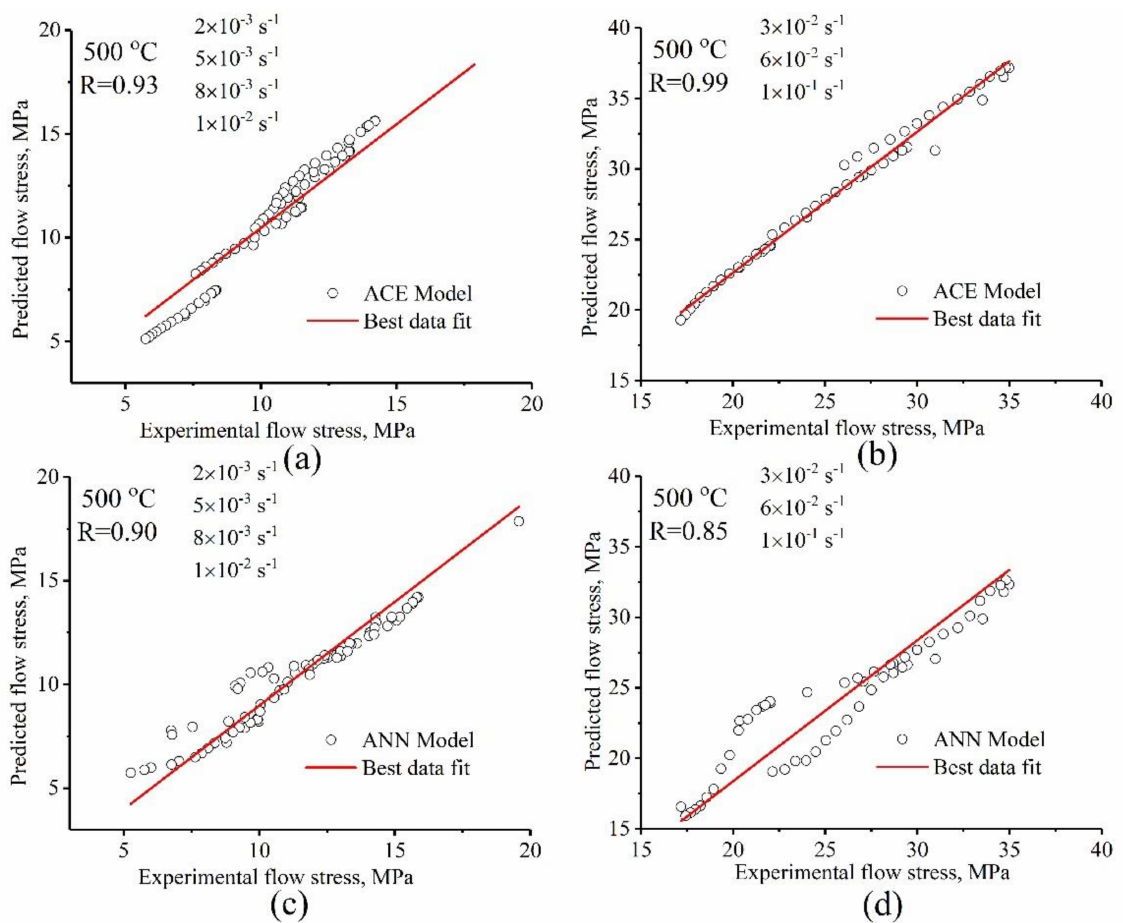
Figure 14. Correlation between the experimental and predicted flow stress obtained by ( a , b ) ACE and ( c , d ) ANN models at ( a , c ) 0.002–0.01 s − 1 and ( b , d ) 0.03–0.1 s − 1